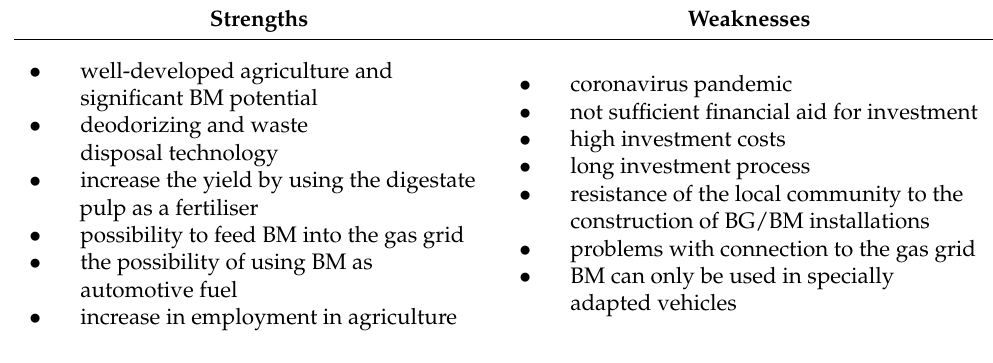
Table 3. SWOT analysis of BG/BM plants in